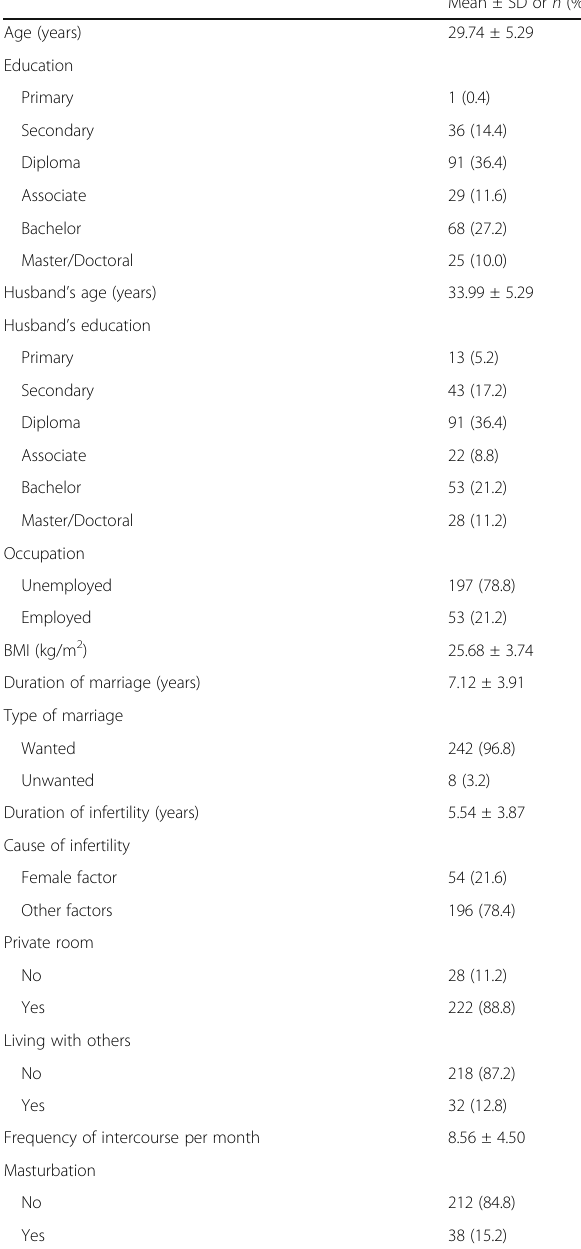
Table 1 Demographic/fertility characteristics of the